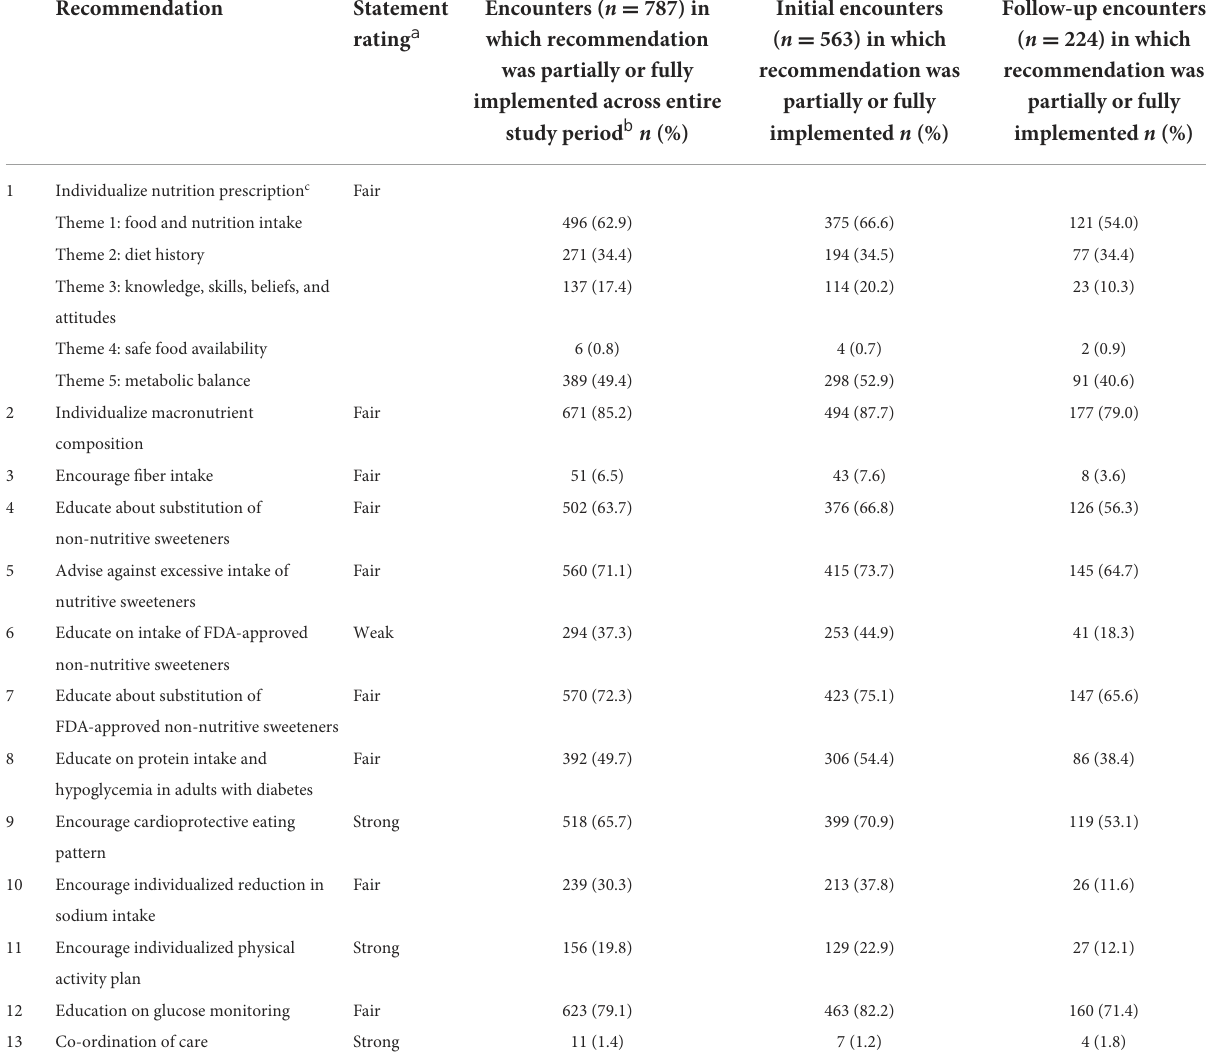
TABLE 2 Percentage of documented registered dietitian nutritionist (RDN) encounters with patients with diabetes in which each imperative intervention recommendation in the diabetes type 1 and 2 evidence-based nutrition practice guideline was partially or fully implemented as assessed by the diabetes expected care plan analyzer ( n = 787 patient encounters for 562 patients). Recommendation Statement Encounters ( n = 787) in Initial encounters Follow-up encounters rating a which recommendation ( n = 563) in which ( n = 224) in which was partially or fully recommendation was recommendation was implemented across entire partially or fully partially or fully study period b n (%) implemented n (%) implemented n